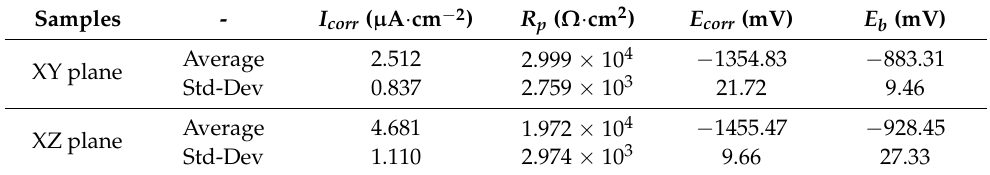
Table 1. Fitting results of polarization curves for as-built samples on different